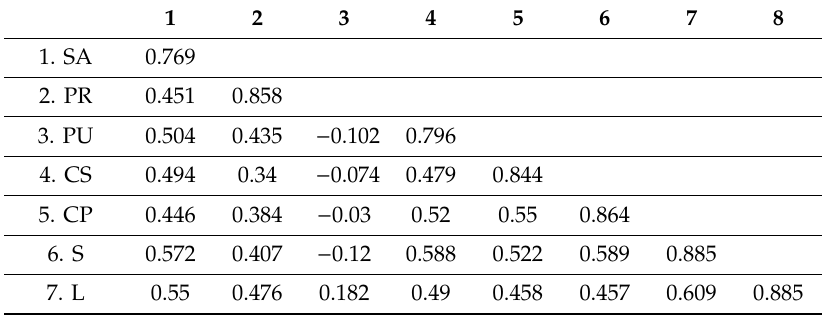
Table 5. Analysis of discriminate